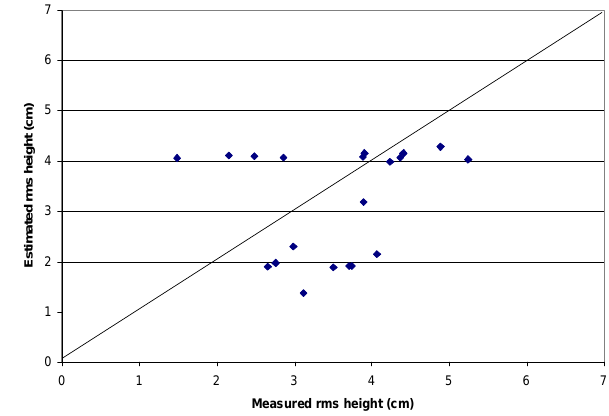
Fig. 6. Scatter plot of rms height measured and estimated by MDM.